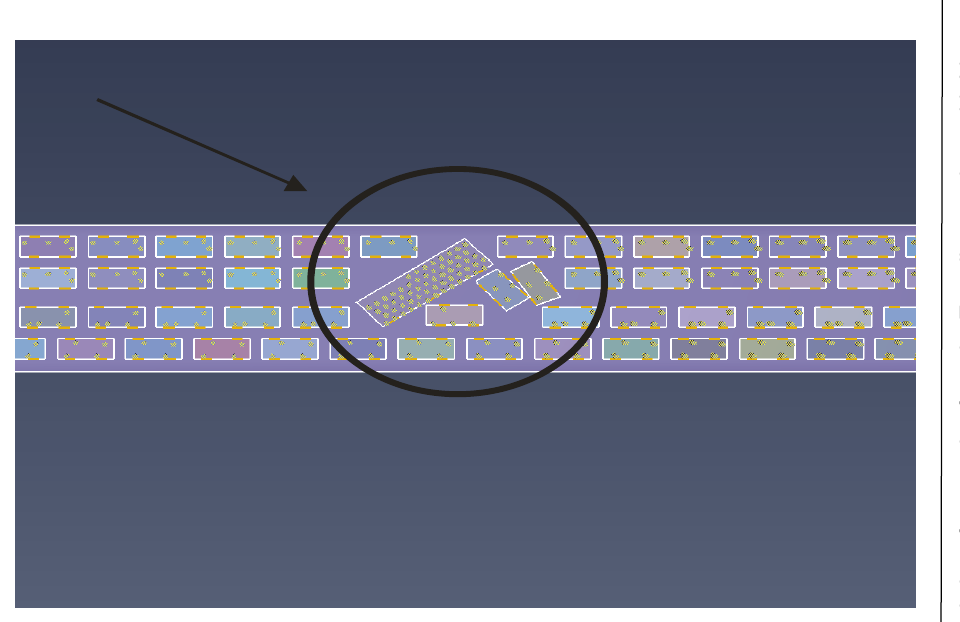
Figure 5 – Simulation presentation of the tunnel with the marked position of a collision (the second simulation